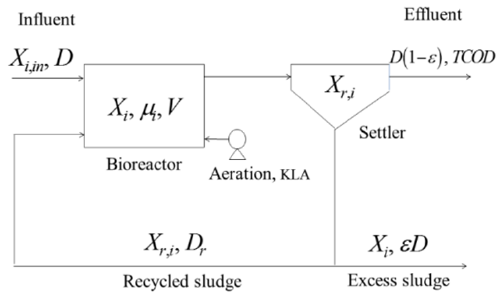
Figure 6. Wastewater plant configuration.